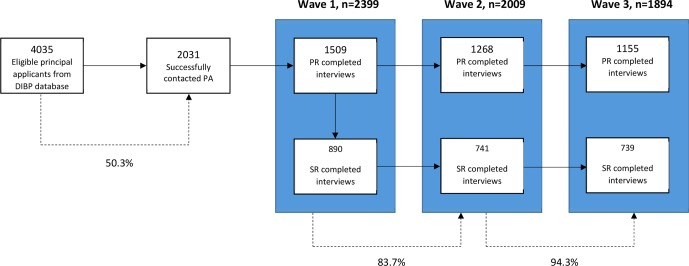
Flowchart of participants. Sampling process resulting in baseline interview completion rates of principal and secondary applicants. Author’s own figure. These sample counts are unweighted. DIBP, Department of Immigration and Border Protection. PA, principal applicants. PR, principal respondents. SR, secondary respondents. % = represents percentage participants retained between stages.